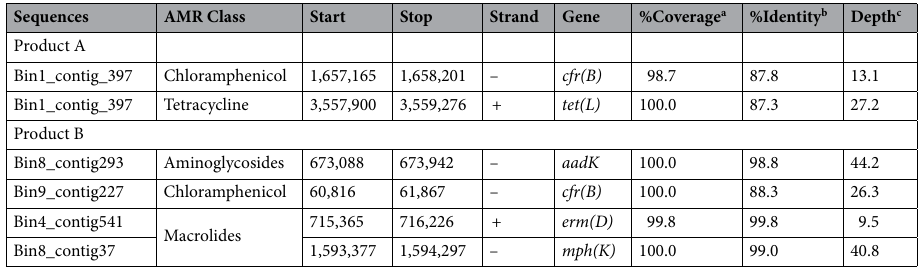
Table 2. Occurrence of potential antimicrobial resistance (AMR) genes predicted from metagenome- assembled genomes (MAGs) of animal probiotic products. a Percentage of DNA coverage (cut-off minimum DNA %coverage at 80). b Percentage of DNA identity (cut-off minimum DNA %identity at 80). Depth is an average number of mapped raw reads against putative predicted AMR gene